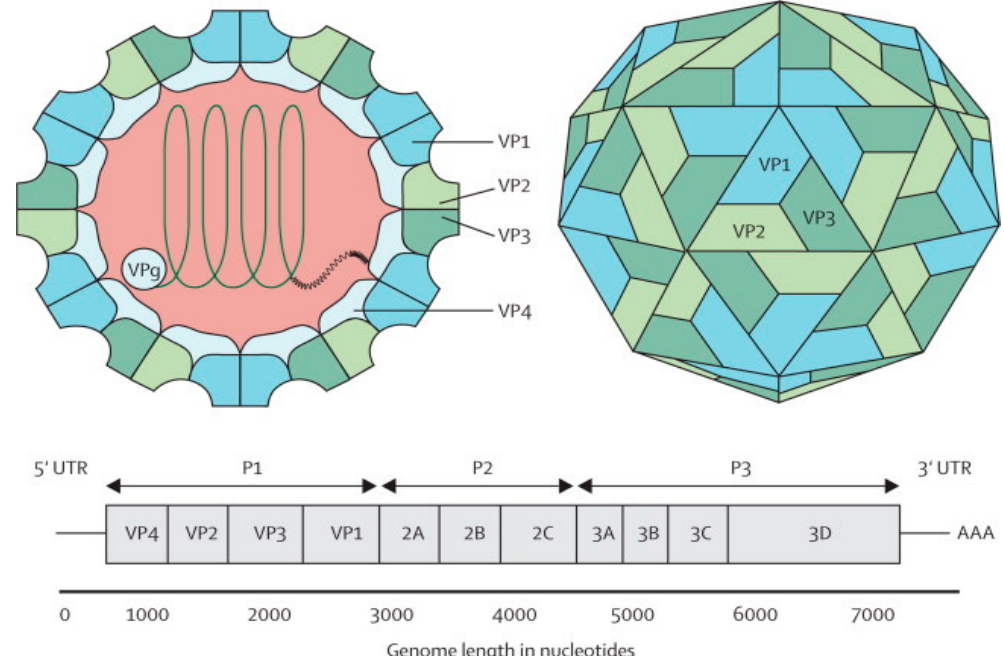
Figure 1. Structure and genome of Enterovirus 71. The capsid consists of 60 protomers, each consisting of four polypeptides that comprise the structural proteins: VP1, VP2, VP3, and VP4 and are encoded by the P1 region of the genome. The P2 and P3 regions encode for seven non-structural proteins: 2A–2C and 3A–3D (the EV-A71 genome is represented by the green line, followed by poly-A residues at the 3 ′ UTR). Reproduced from ViralZone, with permission from Swiss Institute of Bioinformatics [12].